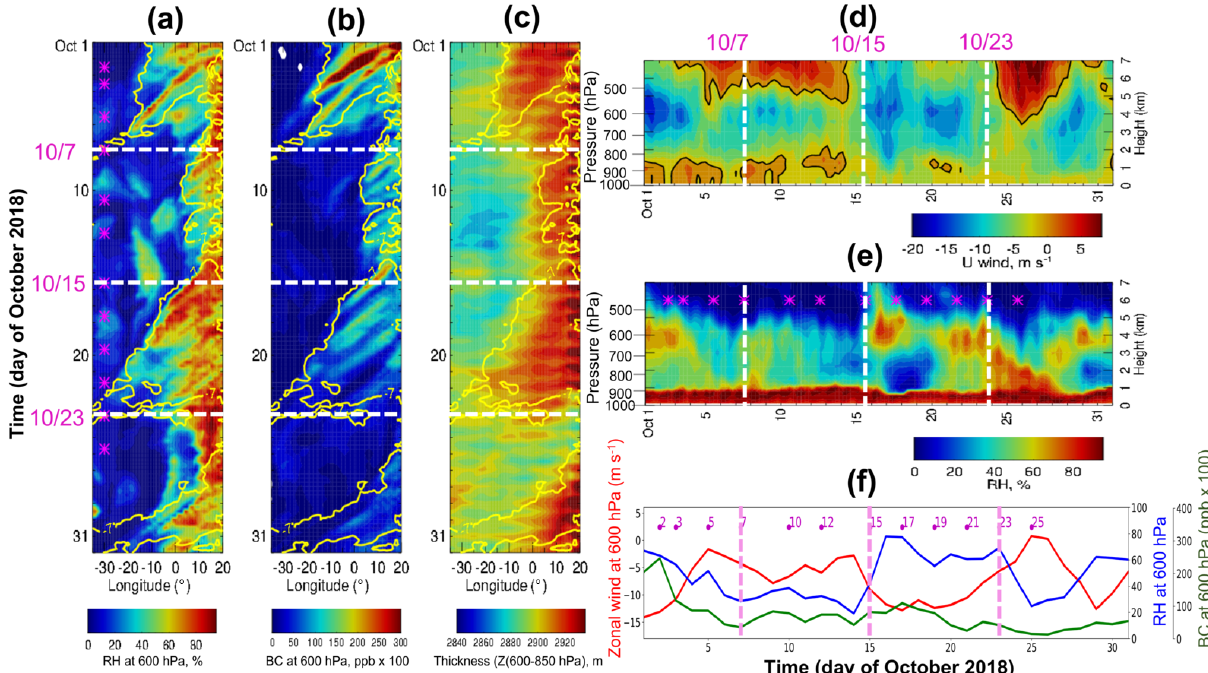
Figure 12. Longitude–time cross section of every 6h of (a) 600hPa RH (%), (b) 600hPa BC aerosol (shading; ppb × 100), and (c) thickness (geopotential height difference of 600–850hPa; high values over a southern African plateau represents the heat low; m) averaged over 8– 10 ◦ S during October 2018. Panels (a) – (c) are overlaid by 600hPa zonal wind isotach (yellow line; − 7ms − 1 ). (d–e) Altitude–time cross section of zonal wind and RH at 10 ◦ S, averaged over 0–10 ◦ E during October 2018. The black contour in panel (d) represents the zero value. (f) Daily time series of the 600hPa zonal wind (red line; ms − 1 ), 600hPa RH (blue line; %), 600hPa BC (green line; ppb × 100) averaged over 8–10 ◦ S and 0–10 ◦ E. The dashed white lines indicate the flight days investigated further in this study, and the magenta asterisks (and numbers in panel f ) represent the flight days during the October 2018